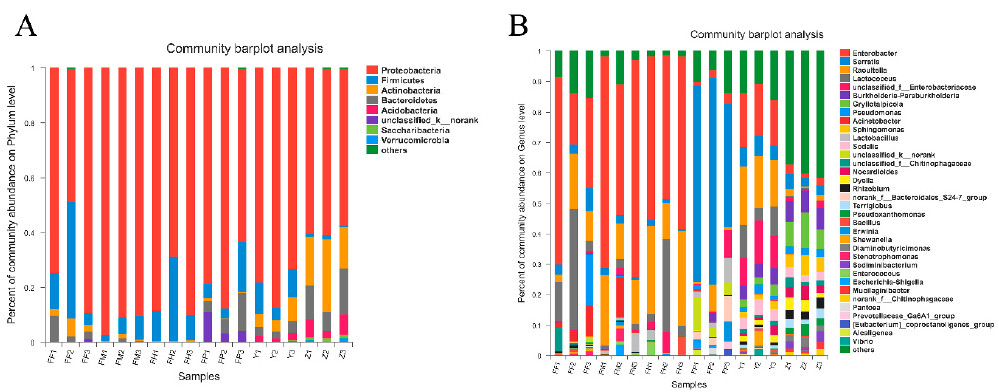
Figure 5. Relative abundance of microbial phyla and genera in intestine samples of M. alternatus and tissue samples of P. massoniana . Relative abundance of dominant microbial phyla ( A ; abundance ≥ 1%) and genera ( B ; abundance ≥ 2%) in larval foreguts, midguts, hindguts, pupal guts, pupal chamber tissues, and larval gallery tissues.